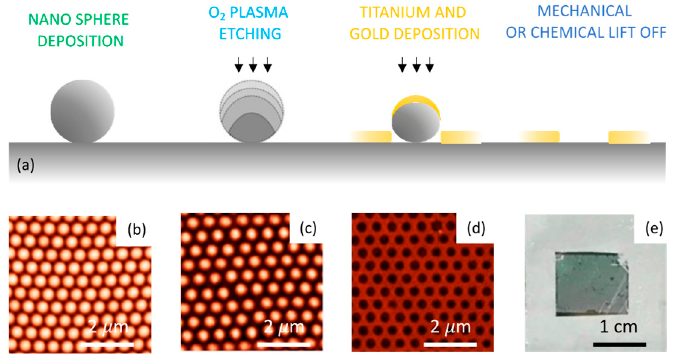
Figure 6. ( a ) Schematic illustration of the NHA fabrication process; AFM image of the ( b ) CPA of PS particle deposited onto a glass substrate, ( c ) non-CPA obtained with an oxygen plasma treatment of the PS nanosphere; ( d ) AFM image and ( e ) photograph of the NHA obtained after mechanical and chemical PS Mask lift off.